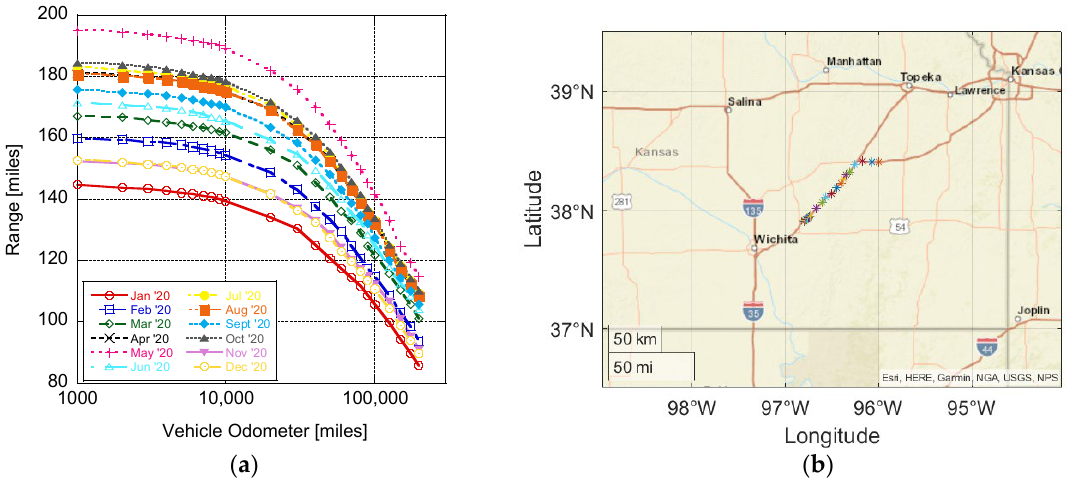
Figure 16. ( a ) Range of Tesla Model S on I-35 S starting from Kansas City, MO, as a function of the time of year and number of miles on the odometer with the HVAC system turned on. ( b ) The respective stopping points of the first leg indicated by the symbols * as the vehicle ages using November 2020 as the month.